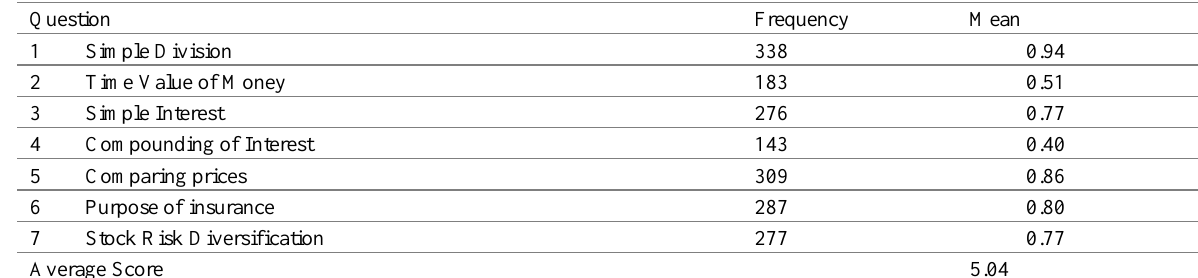
Table 3: Concepts Correctly Answered by